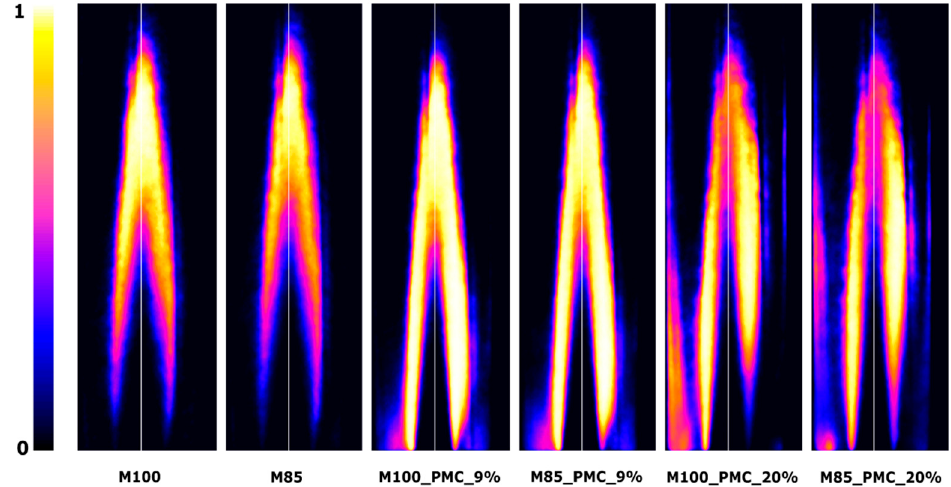
Figure 11. Examples of OH-PLIF images (scaled min–max) for M100 and M85 fuels, with PMC at 0.25 MPa and ϕ = 0.63.